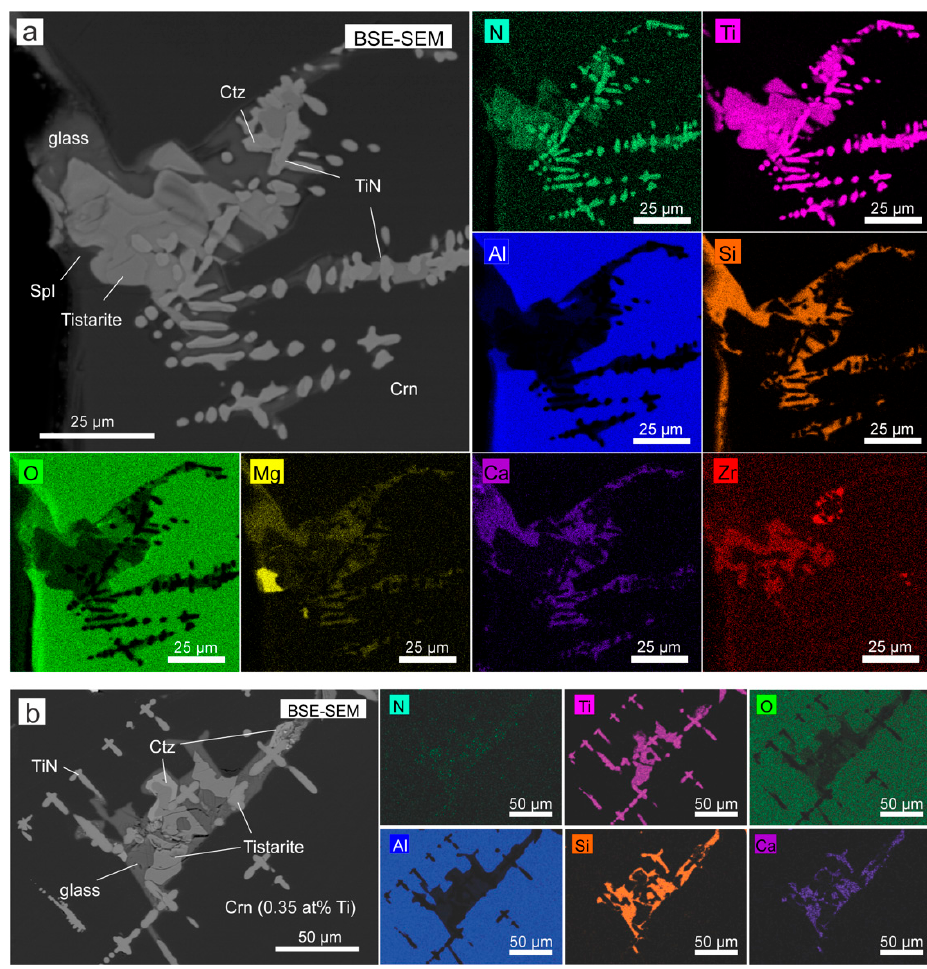
Figure 4. ( a ) BSE image and elemental maps of Ti nitride lenses in melt pockets, apparently necking down in two directions. ( b ) BSE image and elemental maps showing TiN apparently filling voids in the orthogonal structure of the skeletal corundum crystal, and necking down through further growth of the corundum. After [12]. Ctz = carmeltazite (ZrAl 2 Ti 4 O 11 ).